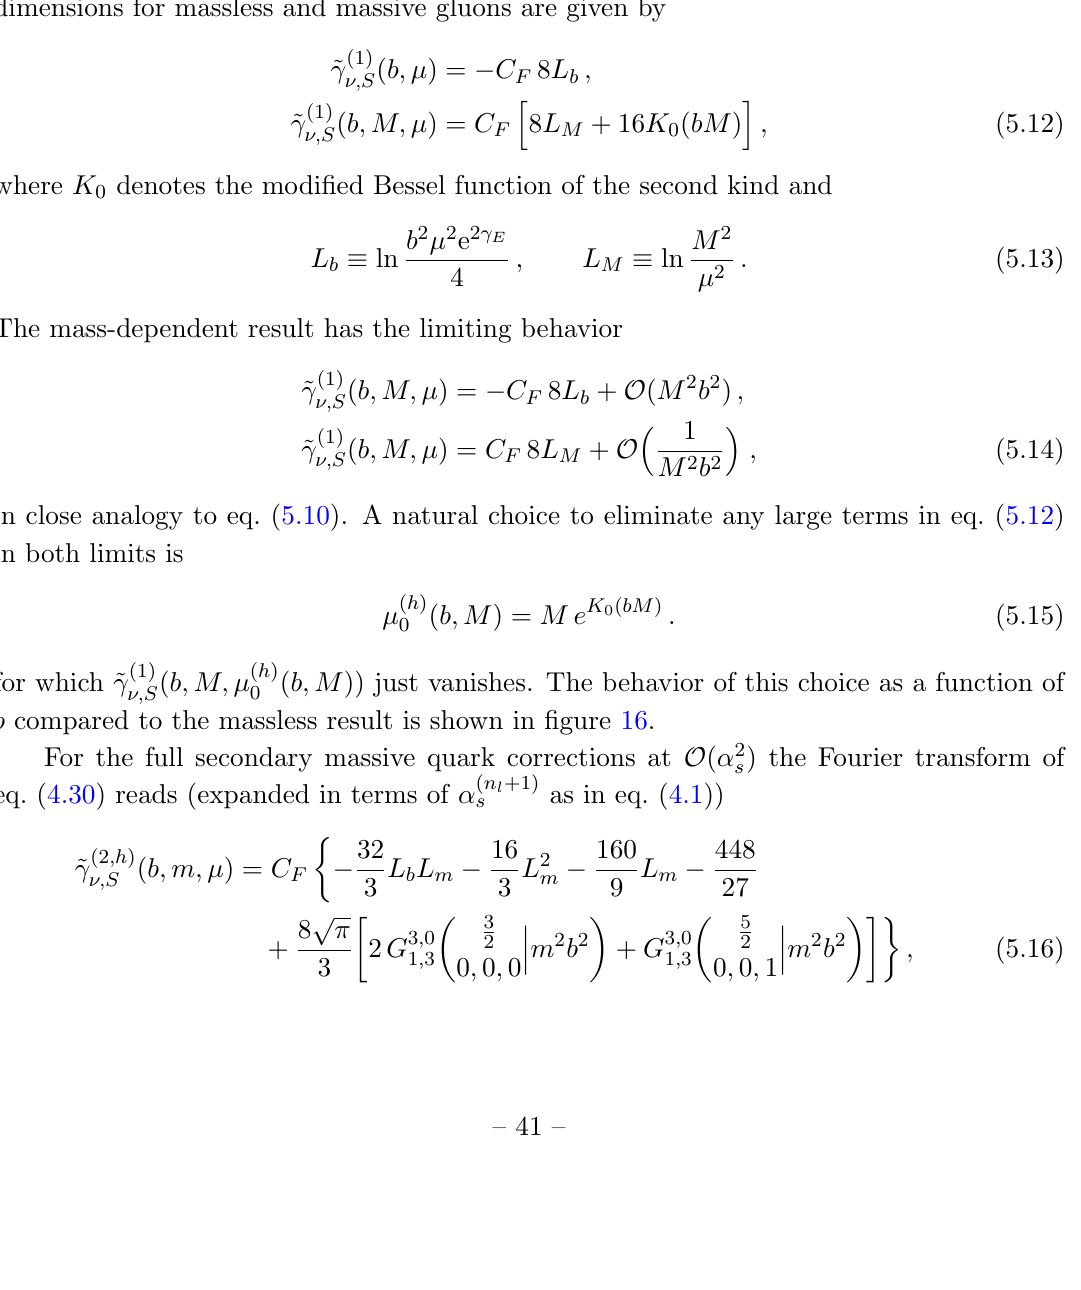
( b; M ) for the massive case (red, solid) and (cid:22) ( l ) 0